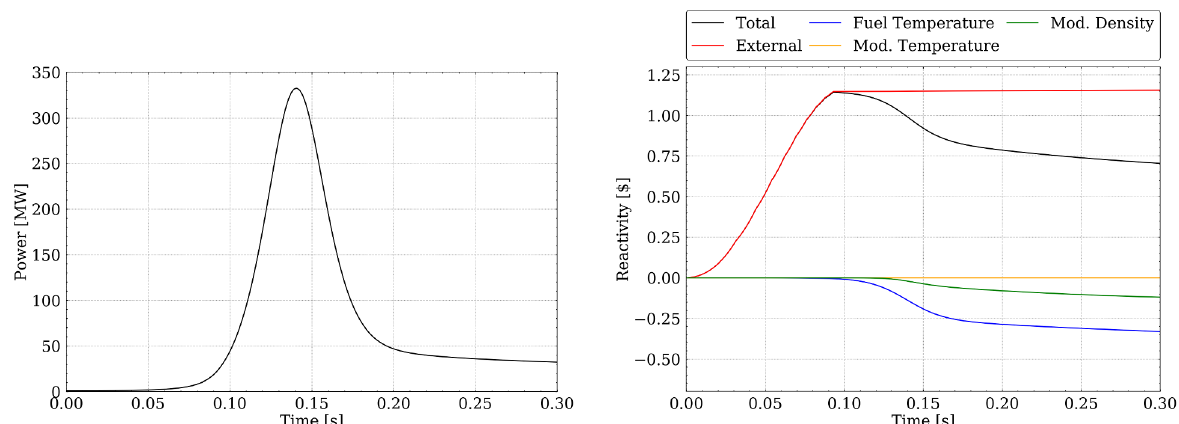
Figure 4: Power (left) and reactivity contributions (right) as a function of time of Test 81 for hot-standby condition calculated with